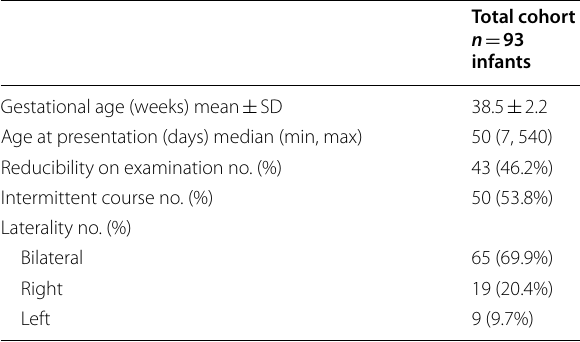
Table 1 Baseline characteristics of the patients and clinical characteristics